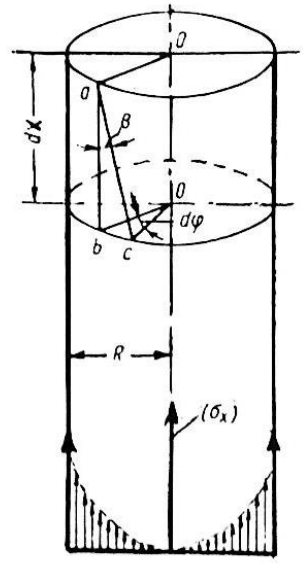
Figure 1. Principle of cylindrical yarn shape.